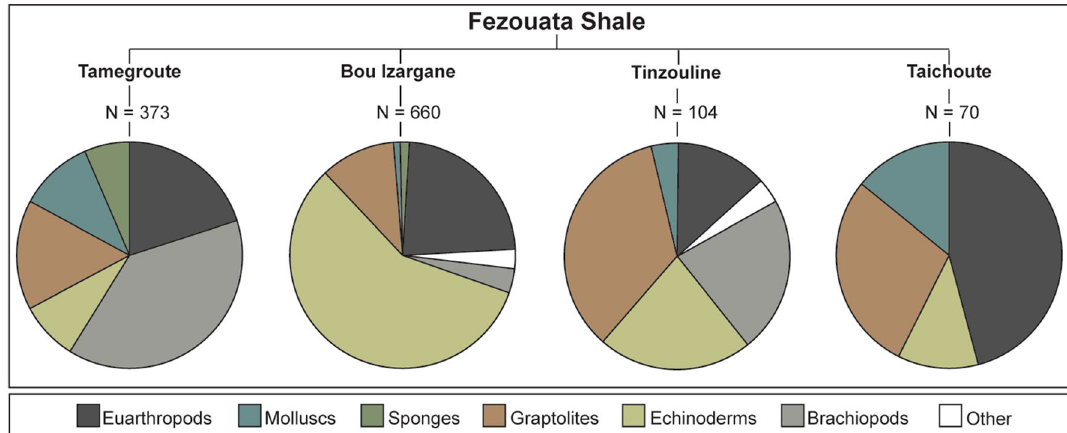
Figure 2. Faunal composition and specimen abundances for each animal group at different Fezouata Shale localities based on the Marrakech Collections of the Cadi Ayyad University (Morocco). Note that the pie chart for Taichoute excludes the accumulation level of brachiopods and bryozoans (above a3, at the top of the succession), as it is impossible to count fossil specimens on this bed. This figure does not account for all specimens recovered/observed at outcrops. For information on how this data was collected and plotted, kindly refer to the Material and Methods